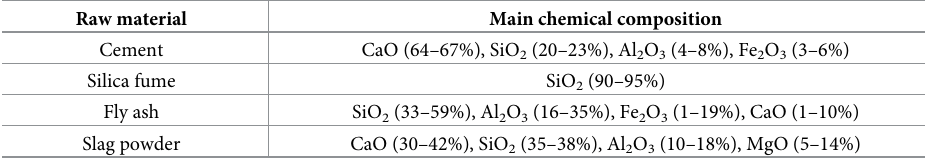
Table 1. Chemical composition of the main raw